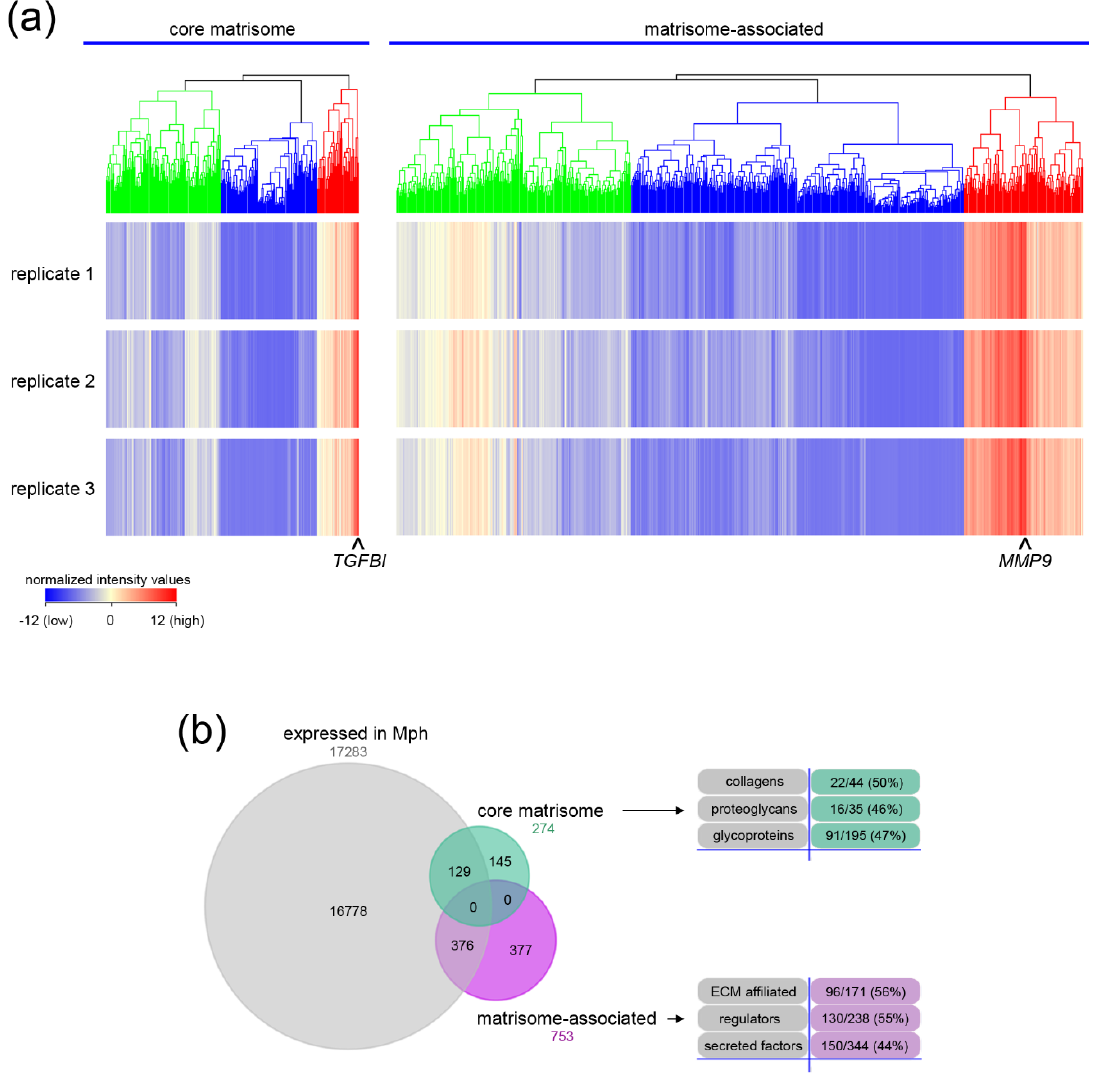
Figure 1. Transcriptome analysis of the matrisome of primary human macrophages. ( a ) Non-averaged hierarchical clustered intensity plot (distant metrics–euclidean, linkage rule–ward’s) of core matrisome and matrisome-associated genes in macrophages is shown. Clusters of intermediate (green), low (blue) and high (red) expression are highlighted. The normalized intensity values of the individual replicates are shown. The highest expressed gene within the core matrisome TGFBI (transforming growth factor beta induced) and the matrisome-associated MMP9 (matrix metalloproteinase 9) are indicated. ( b ) The proportion of entities within the core matrisome or matrisome-associated cluster are shown in a Venn diagram. The numbers and percentages of regulated genes found in subcategories are listed.